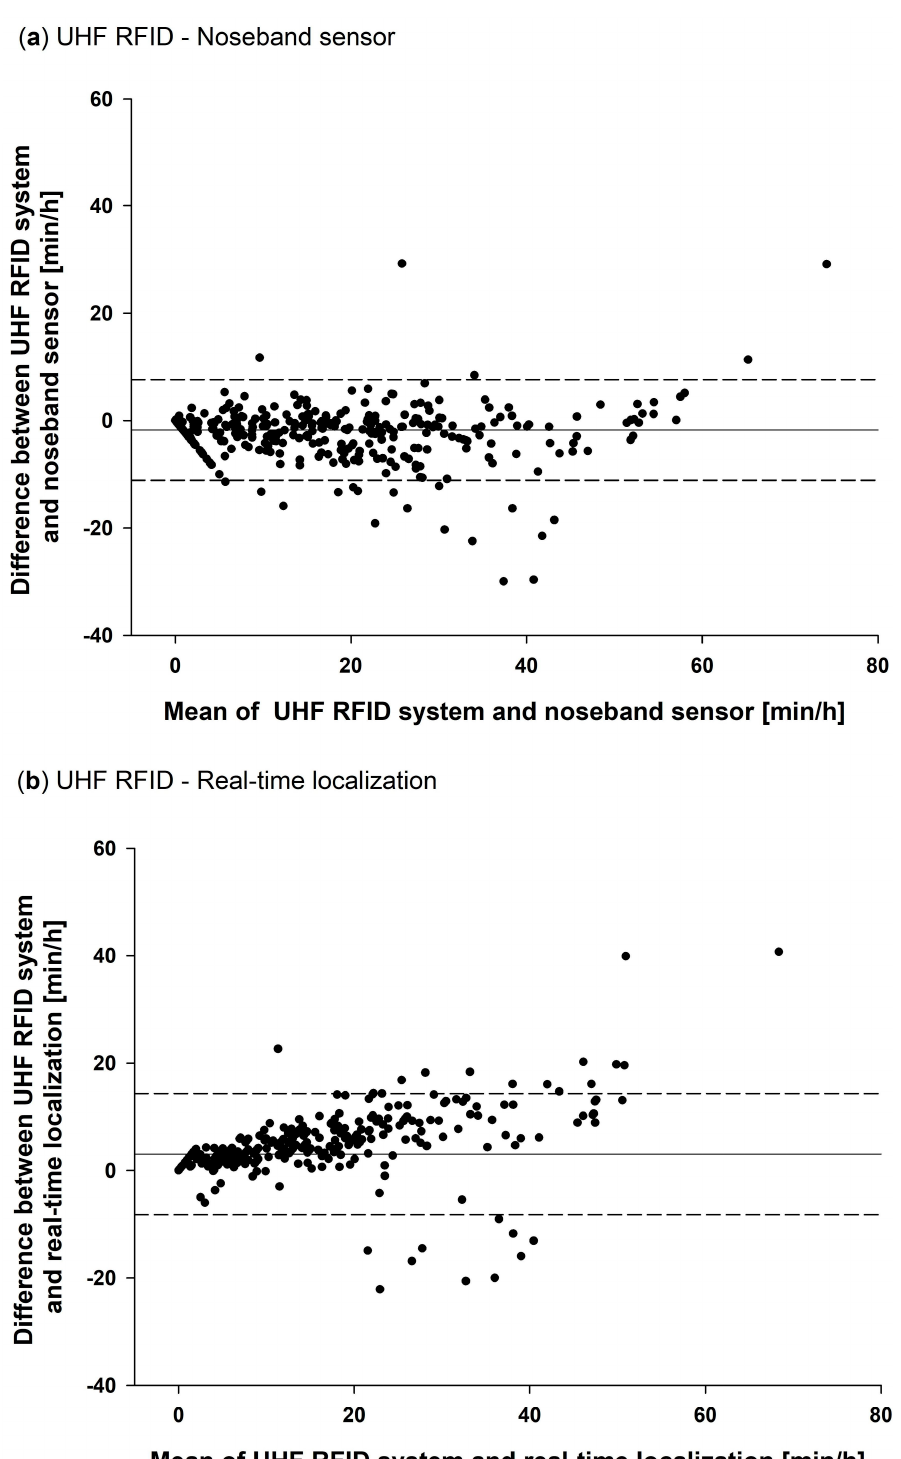
Figure 9. Agreement of the 1-hour summaries of time spent at the feed fence measured with the UHF RFID system versus ( a ) eating time of the RumiWatch noseband sensor and versus ( b ) the time spent at the feed fence extracted from the real-time localisation data of the Smartbow ® system shown in Bland–Altman plots. The solid line indicates the mean of the di ff erences, the dashed lines indicate the upper and lower 95% limits of